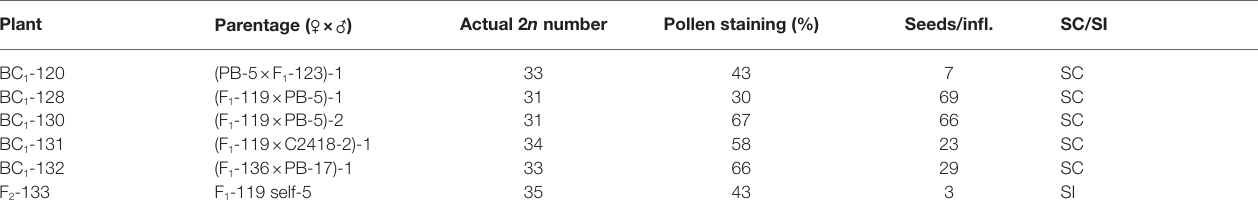
TABLE 2 | BC 1 and F 2 plants selected for detailed analysis, including actual chromosome numbers, pollen fertility, seeds obtained per inflorescence (approx. 50 florets) when crossed with T. repens , and whether self-compatible (SC) or self-incompatible (SI).